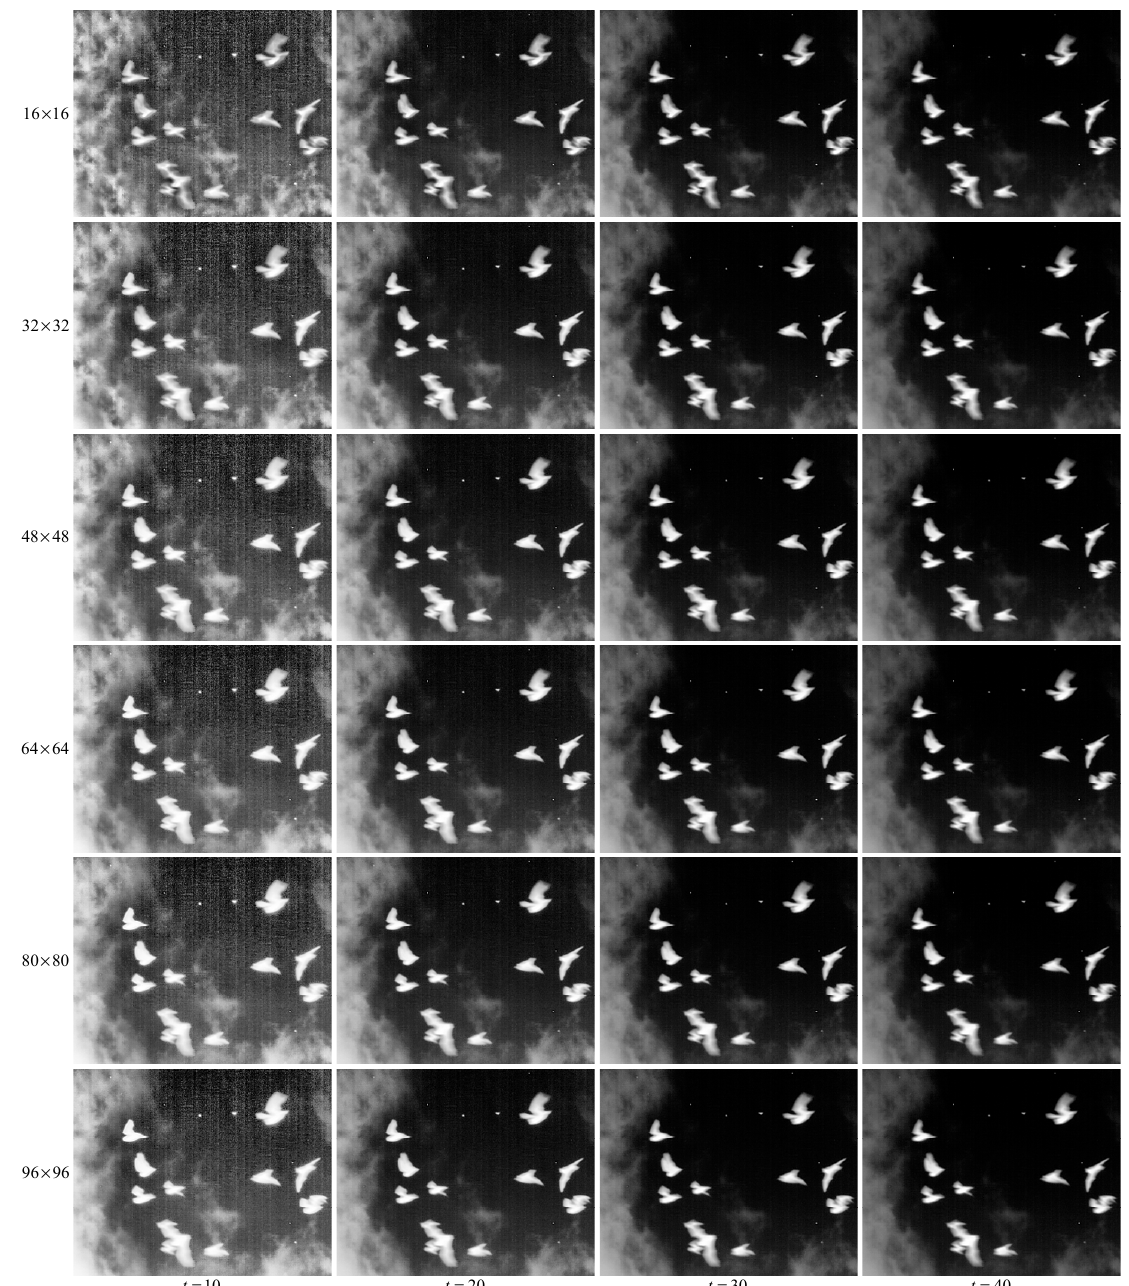
Figure 7. The enhanced results of the proposed method with different parameter setting.